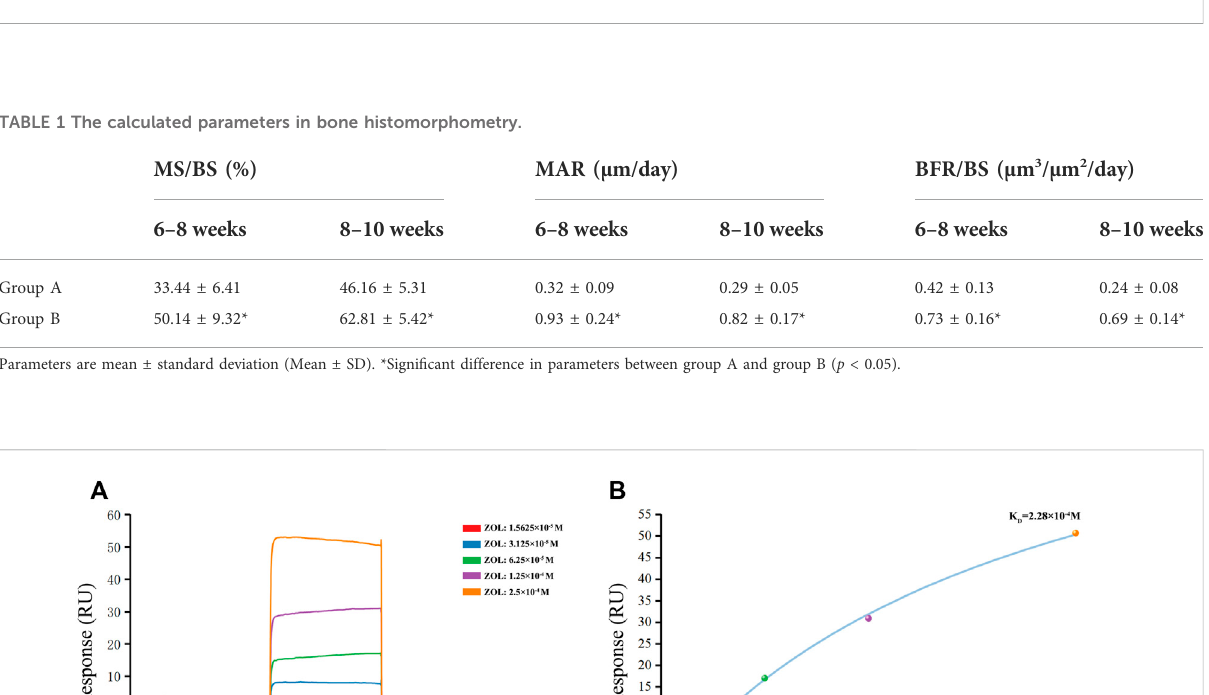
FIGURE 2 Sequential fl uorescentlabelingwasusedbyTE,CAandALatdifferentperiods.Theimageof(A1,A2,A3)and(B1,B2,B3)werelabeledat6,8,and 10 weeks after ZOL/saline solution administration. A4, and B4 represented merged images of the three fl uorochromes for the same group (50×). A and B represented two groups (50×).